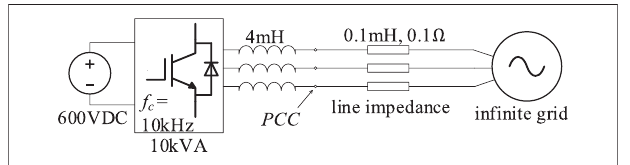
FIGURE 8 | Simulation topology of a VSG connected to the in fi nite grid.